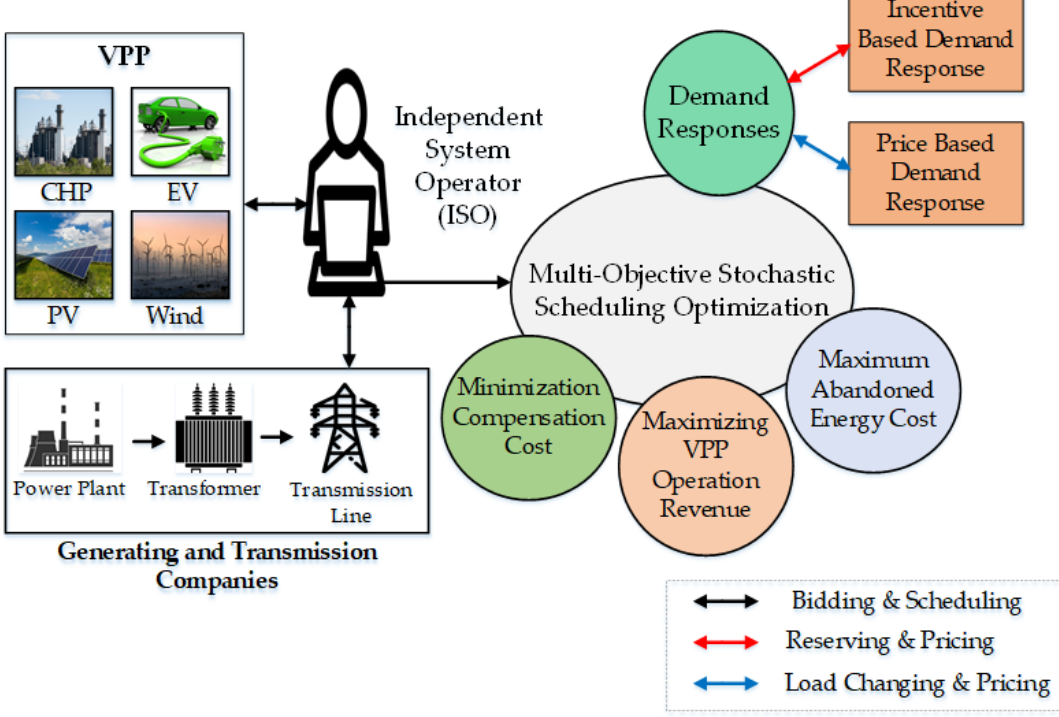
Figure 17. A multi-objective stochastic scheduling optimization model for virtual power plants (Redrawn with permission from [66], 2016, Elsevier) (Note: VPP-virtual power plants; CHP-combined heat and power; EV-electric vehicle; PV-photovoltaics).